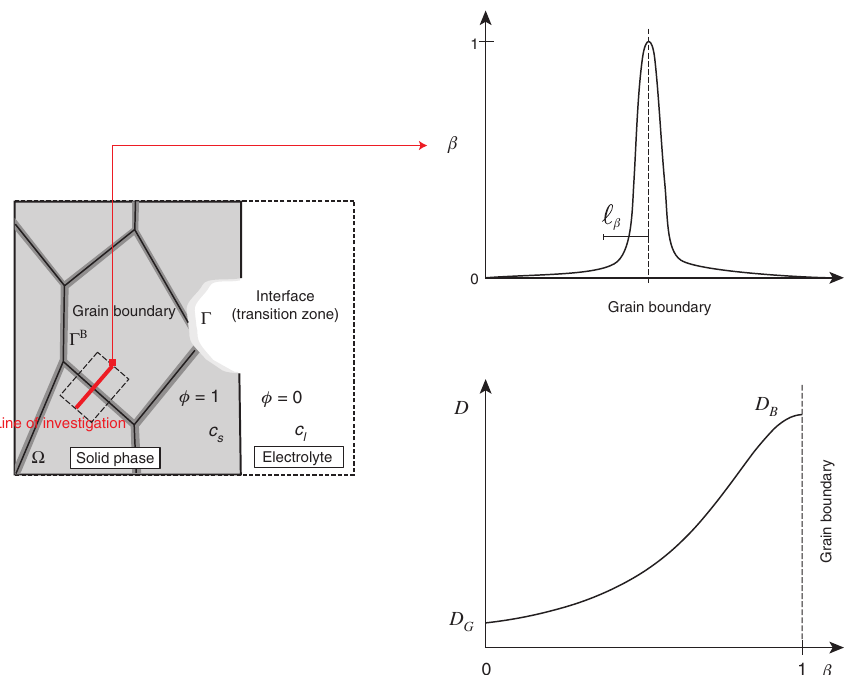
Figure 2: Explicit description of the different electrochemical behavior between grain boundary and grain